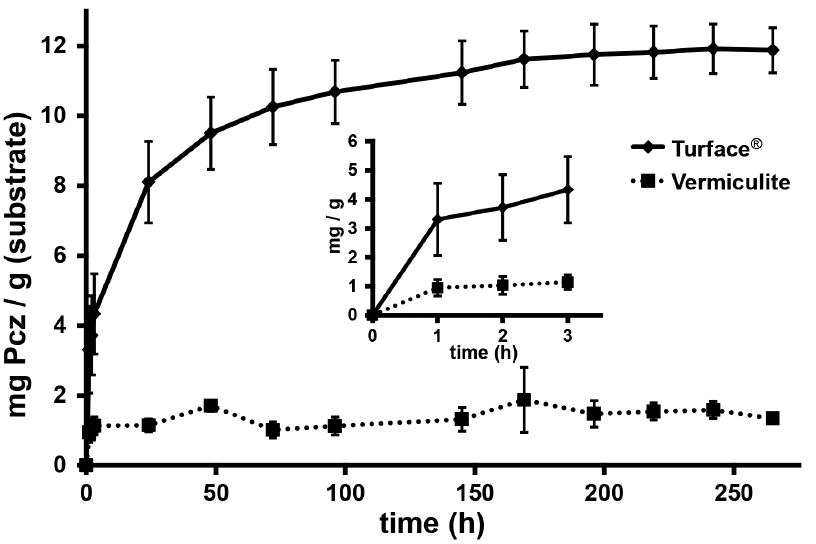
Figure 6. Adsorption isotherms of Pcz to Turface and vermiculite. Adsoprtion isotherms of Pcz absorbance to Turface and vermiculite determined over 250 h. Inset shows absorbance kinetics during the first 3 h of interaction. Error bars represent standard